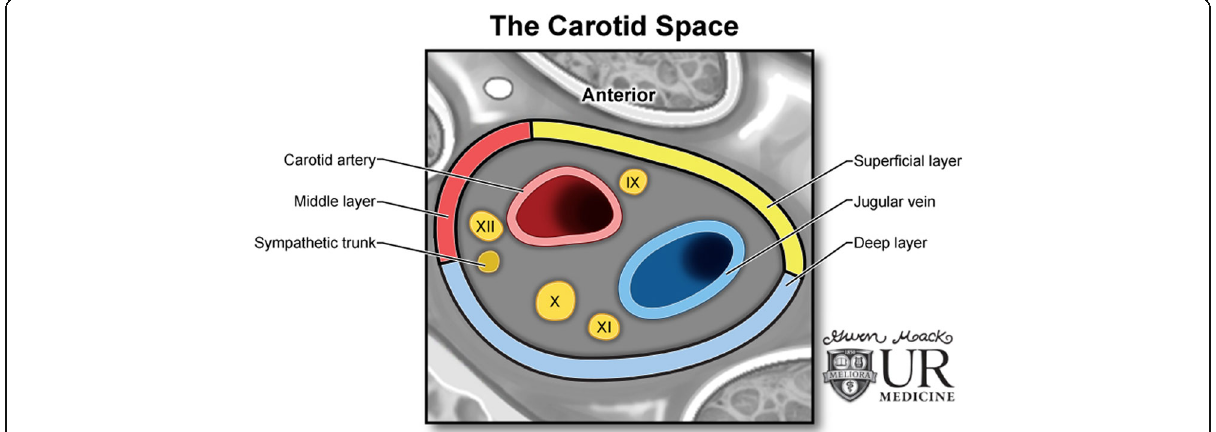
Fig. 1 The carotid space. Illustration demonstrating the contents and configuration of the left carotid space, including cranial nerves IX, X, XI, and